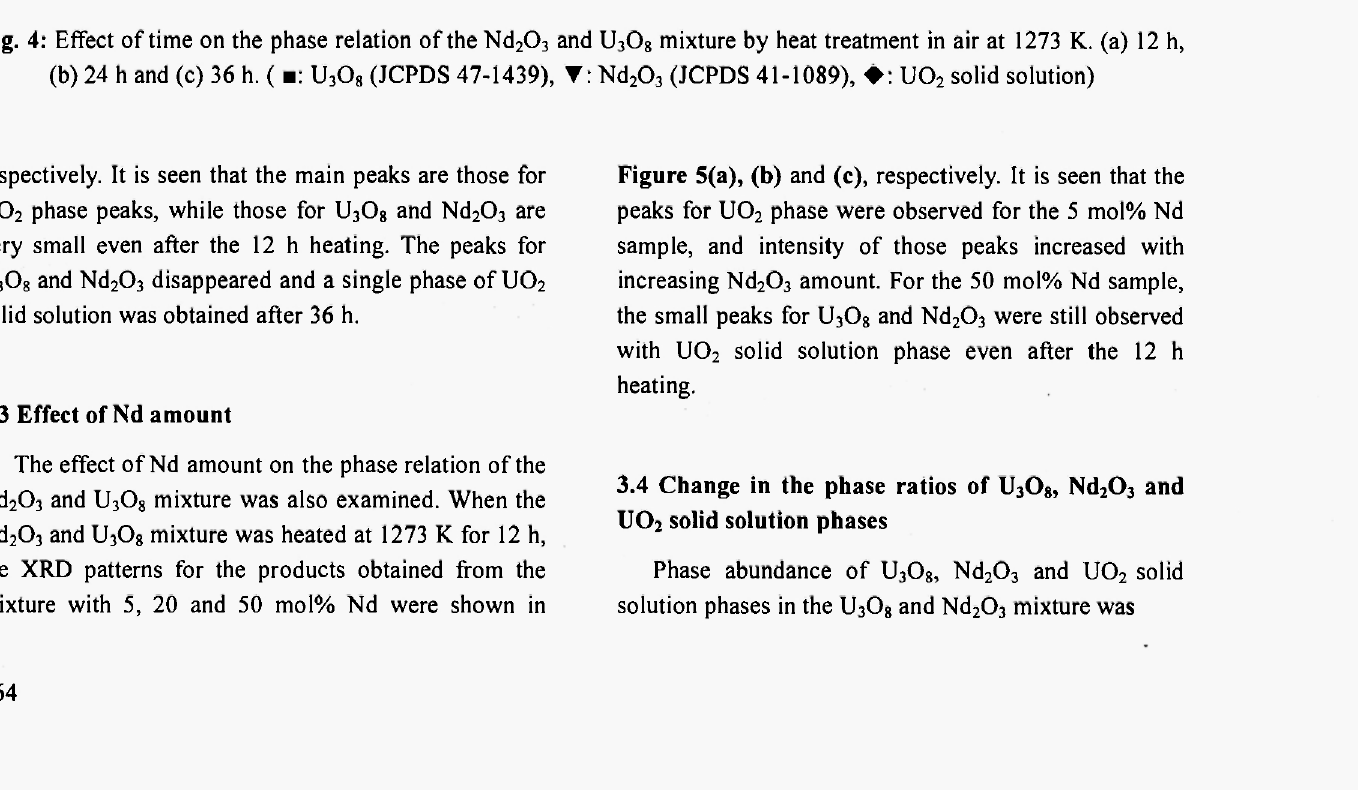
Fig. 4: Effect of time on the phase relation of the Nd 2 0 3 and U 3 0 8 mixture by heat treatment in air at 1273 K. (a) 12 h, (b) 24 h and (c) 36 h. ( •: U 3 O s (JCPDS 47-1439), Nd 2 0 3 (JCPDS 41-1089), U0 2 solid